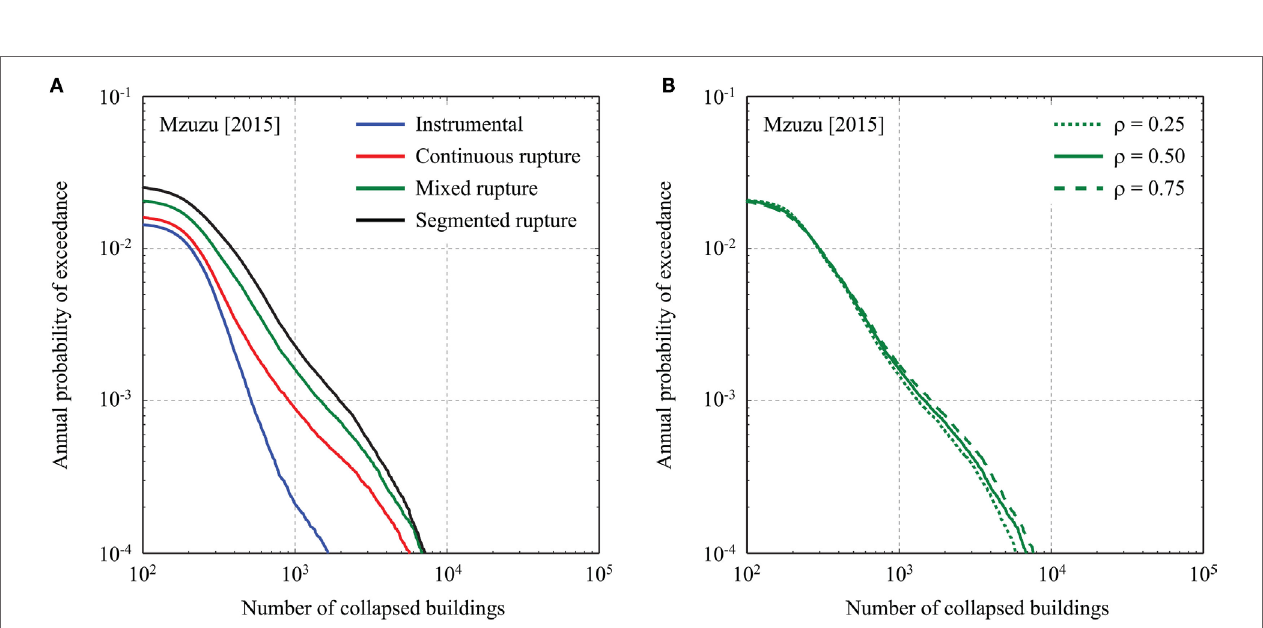
FigUre 12 | (a) Effects of different earthquake occurrence models on building-collapse curves for Mzuzu. (B) Effects of different MMI spatial correlation models (mixed rupture scenario) on building-collapse curves for Mzuzu.